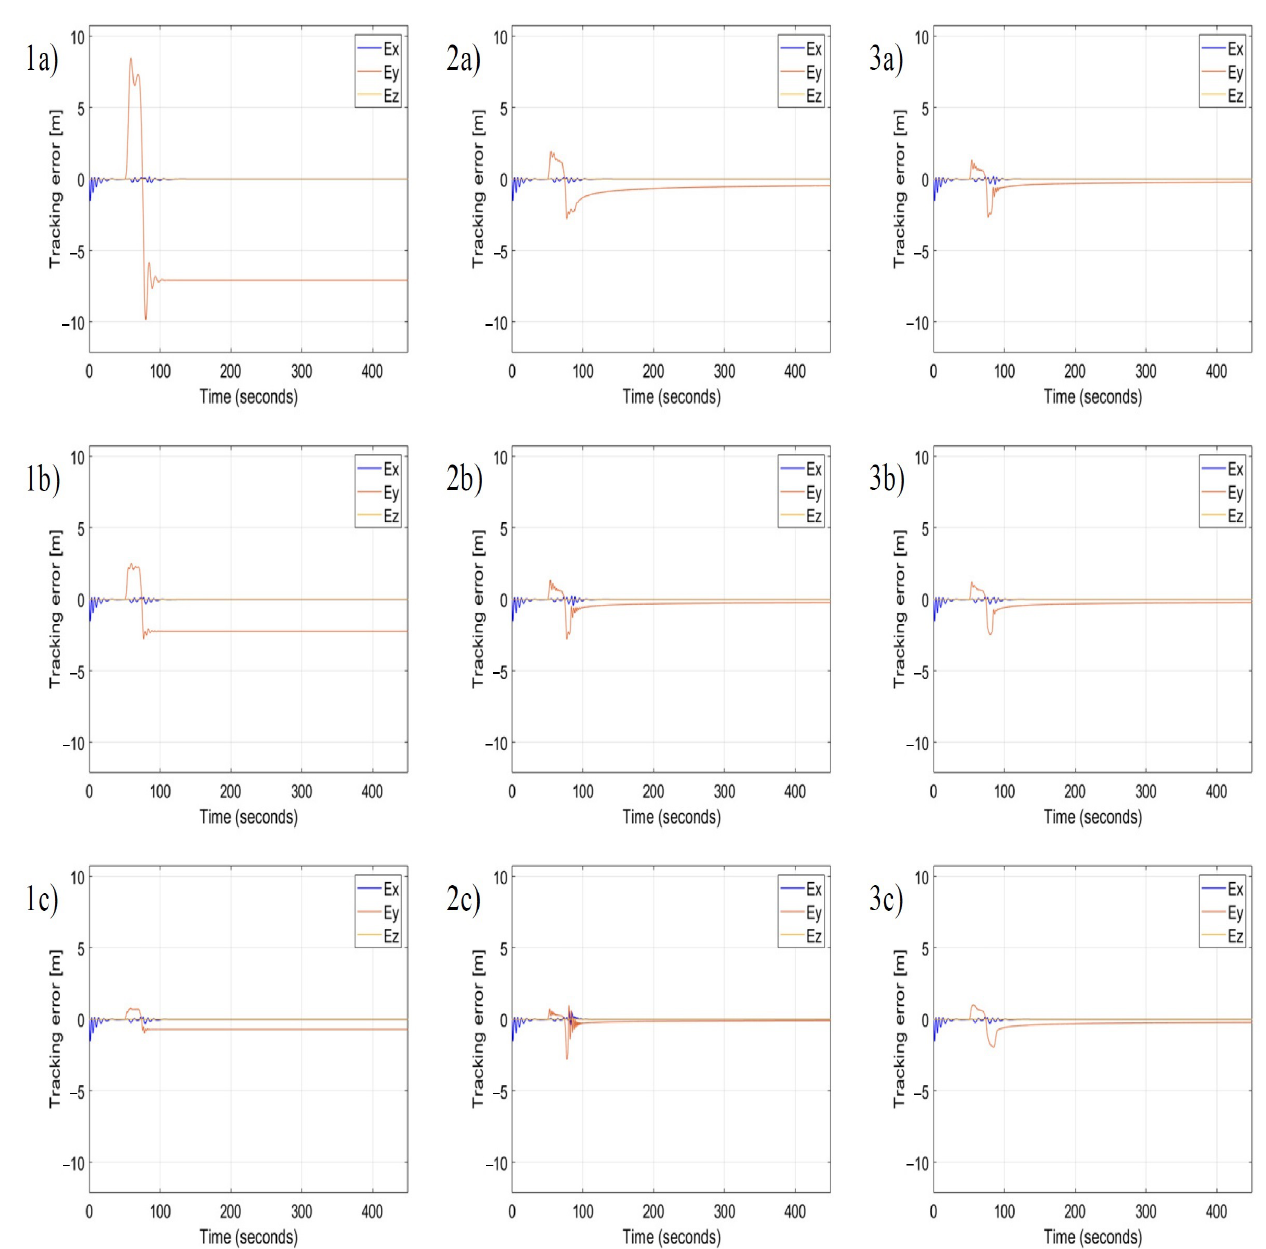
Figure 9. Time plots of position tracking errors for different coefficients γ , δ Iy , δ Iz , δ Dy , and δ Dz for the nonlinear P, PI, and PID controllers in the case of lateral wind gusts. The applied values of the coefficients are given in Table